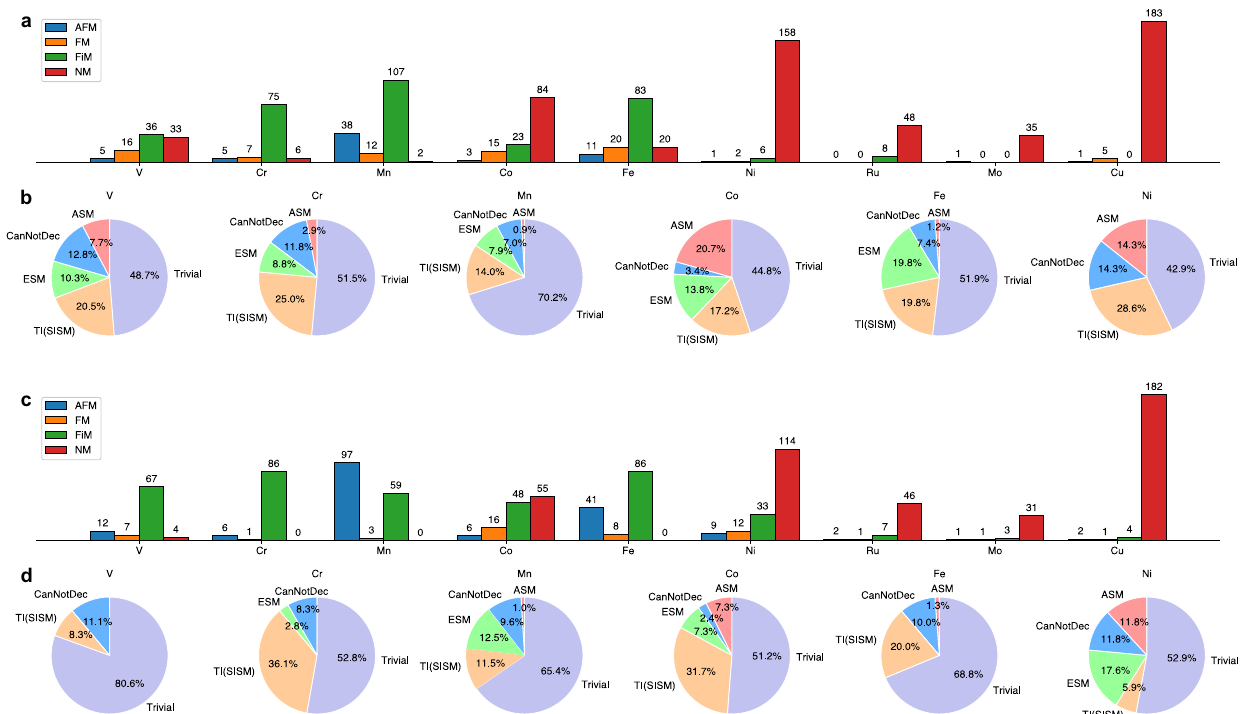
Fig. 2 Summary of magnetic and topological diagnosis of 1049 TMCs. Panels a , b correspond to the calculations without U. In a , each column chart shows the statistic of magnetic ground states theoretically predicted by the work fl ow. Except for Ni, Ru, Mo, and Cu compounds which have dominant nonmagnetic ground states, the ground states of the other compounds display certain magnetic ordering. In b , all materials with predicted magnetic ground states are further examined by topological characterization. Trivial materials and materials that cannot be successfully classi fi ed are over 50%. Our work fl ow identi fi es two categories of magnetic materials: TI(SISM) and semimetals (ESM/ ASM). See the main text for their de fi nitions. Panels c , d are the same as a , b but with U